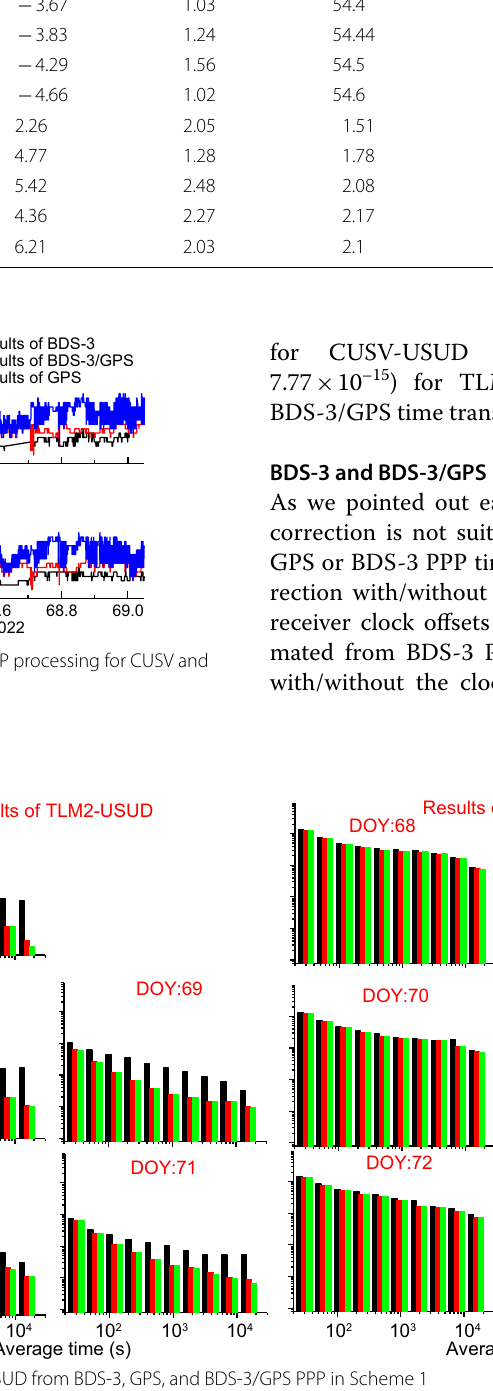
Fig. 7 MDEV of CUSV-USUD and CUSV-USUD from BDS-3, GPS, and BDS-3/GPS PPP in Scheme